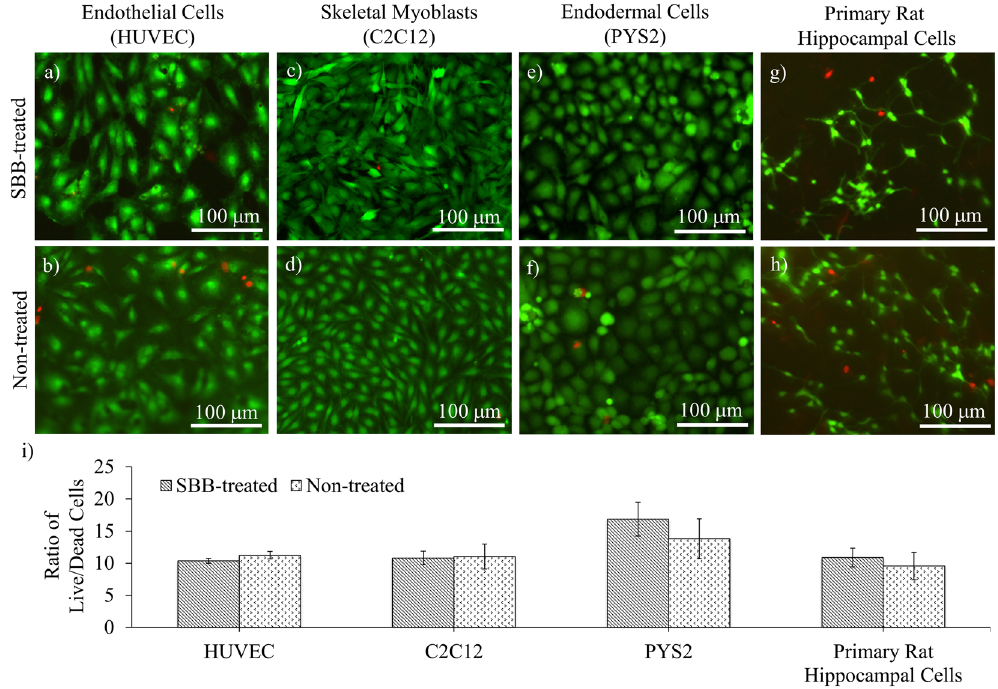
Figure 3. The effect of SBB treatment on live/dead cells ratio. Cell viability of three cell lines, ( a and b ) endothelial cells (HUVEC), ( c and d ) skeletal myoblasts (C2C12), ( e and f ) endodermal cells (PYS2), and ( g and h ) primary cells from rat hippocampi on 0.3% SBB-treated and non-treated PCL slabs were examined by calculating the ratios of live/dead cells ( i ). The cells were stained by live/dead assay on Day 3 of cell culturing. In particular, primary hippocampal neurons can be identified by their neuronal processes. Live cells are labeled in green. Dead cells are labeled in